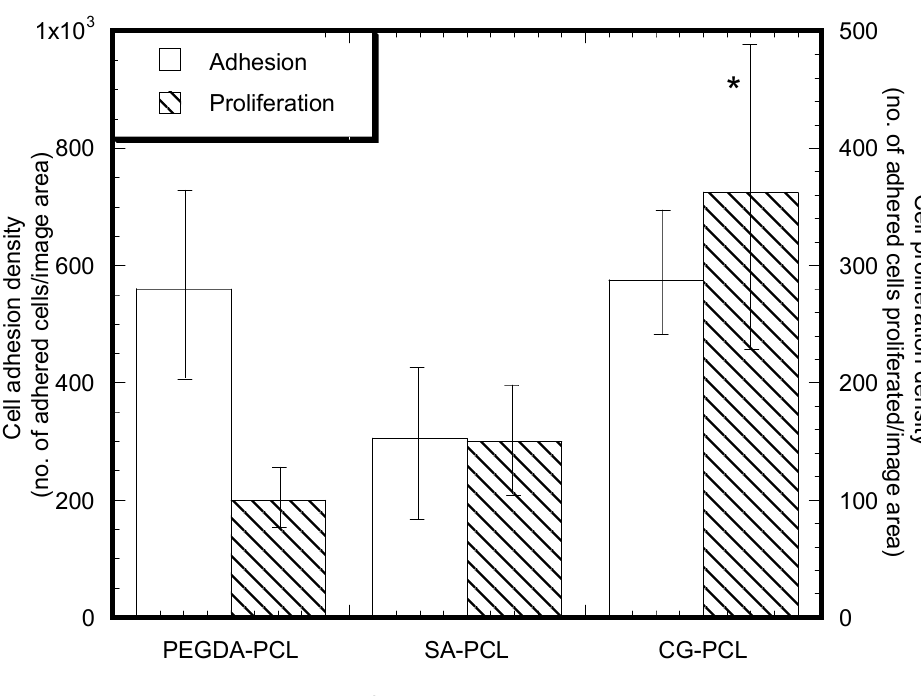
Figure 7. Mean cell adhesion density ( ± standard error) and mean cell proliferation density ( ± standard error) for the PEGDA-PCL, SA-PCL, and CG1-PCL groups. Data are presented with n = 8 for all samples. Note: * p < 0.05 (compared to PEGDA-PCL).